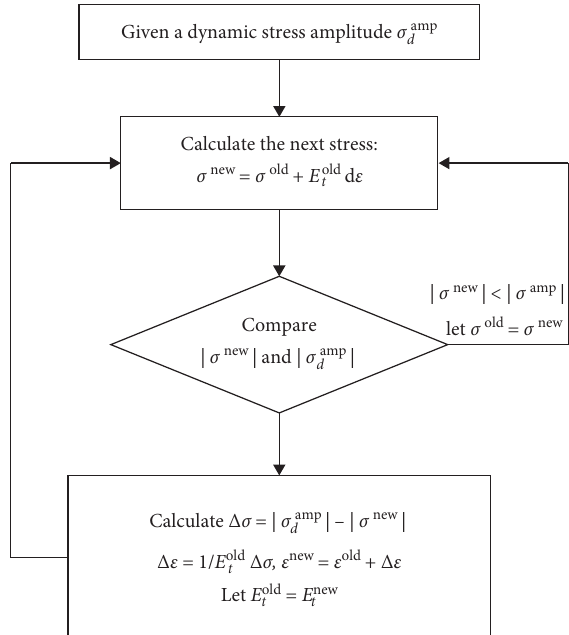
Figure 8: The procedure used in the integration scheme for stress